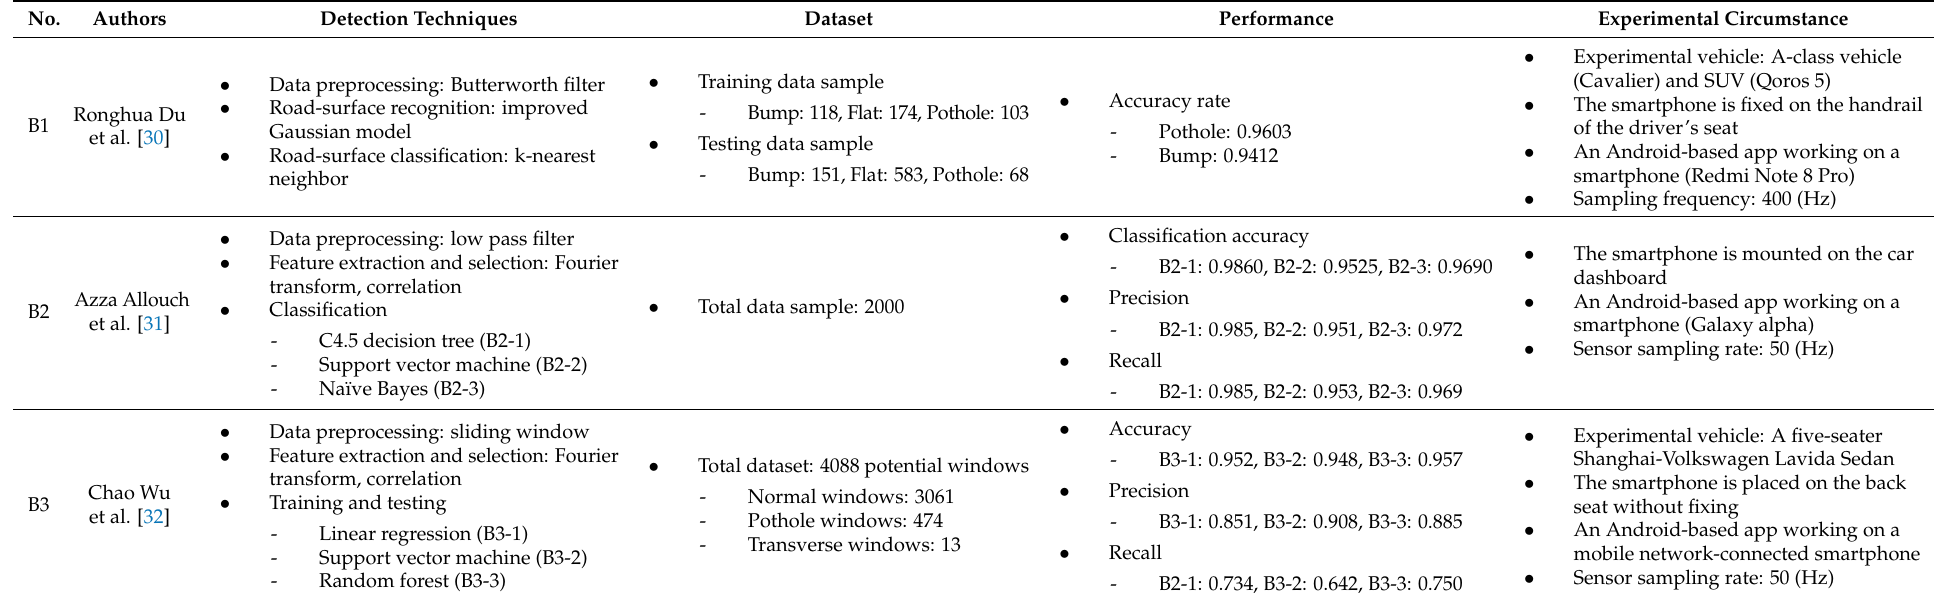
Table 3. Detection techniques and characteristics of vibration-based pothole-detection